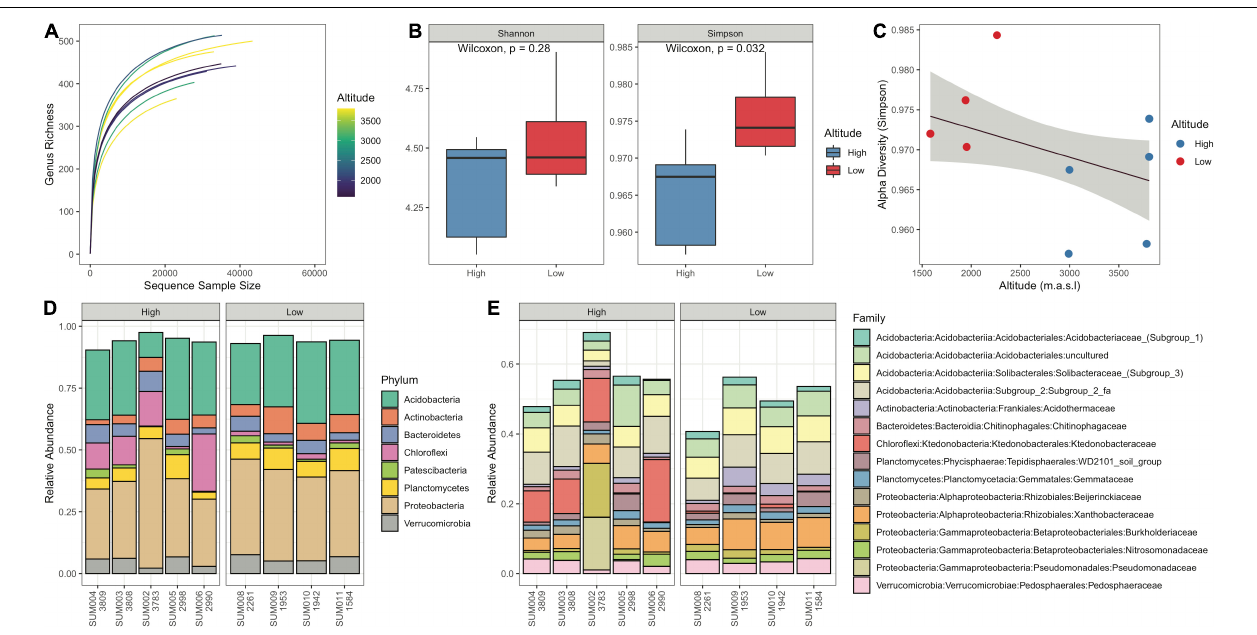
FIGURE 2 | Diversity analysis for soil samples. (A) Rarefaction curves for soil samples. The color palette refers to the altitude at which the sample was collected, warmer colors represent higher altitudes. (B) Boxplot of Shannon and Simpson alpha diversity indexes for soil samples, with their corresponding significance values for a Wilcoxon contrast test. (C) Robust linear regression with the Simpson index as the predicted value and altitude as the predictor, it includes a 95% confidence interval around the regression estimate. (D) Stacked bar plots contrasting high and low samples for the eight most abundant Phyla. Values under each sample name are the corresponding altitudes. (E) Stacked bar plots contrasting high and low samples for the 15 most abundant families in the